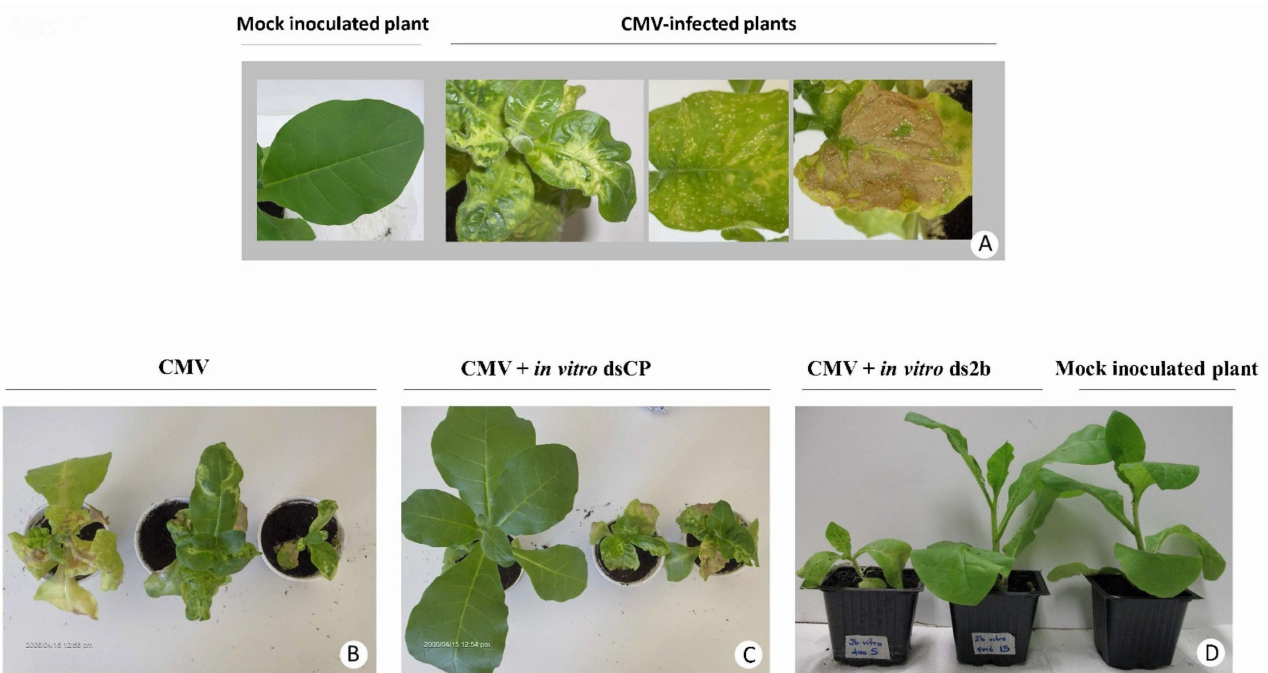
Figure 2. In vitro produced dsRNA molecules confer resistance to tobacco against CMV. ( A ) Range of symptoms of CMV- infected plants in comparison with the mock (water) inoculated plants. ( B – D ) Response of tobacco plants to the application of CMV jointly with in vitro produced dsRNA derived from the cognate virus. The tobacco plants were inoculated with: CMV ( B ), CMV jointly with in vitro dsCP ( C ) or CMV jointly with in vitro ds2b ( D ). Plants were photographed at 14 dpi.